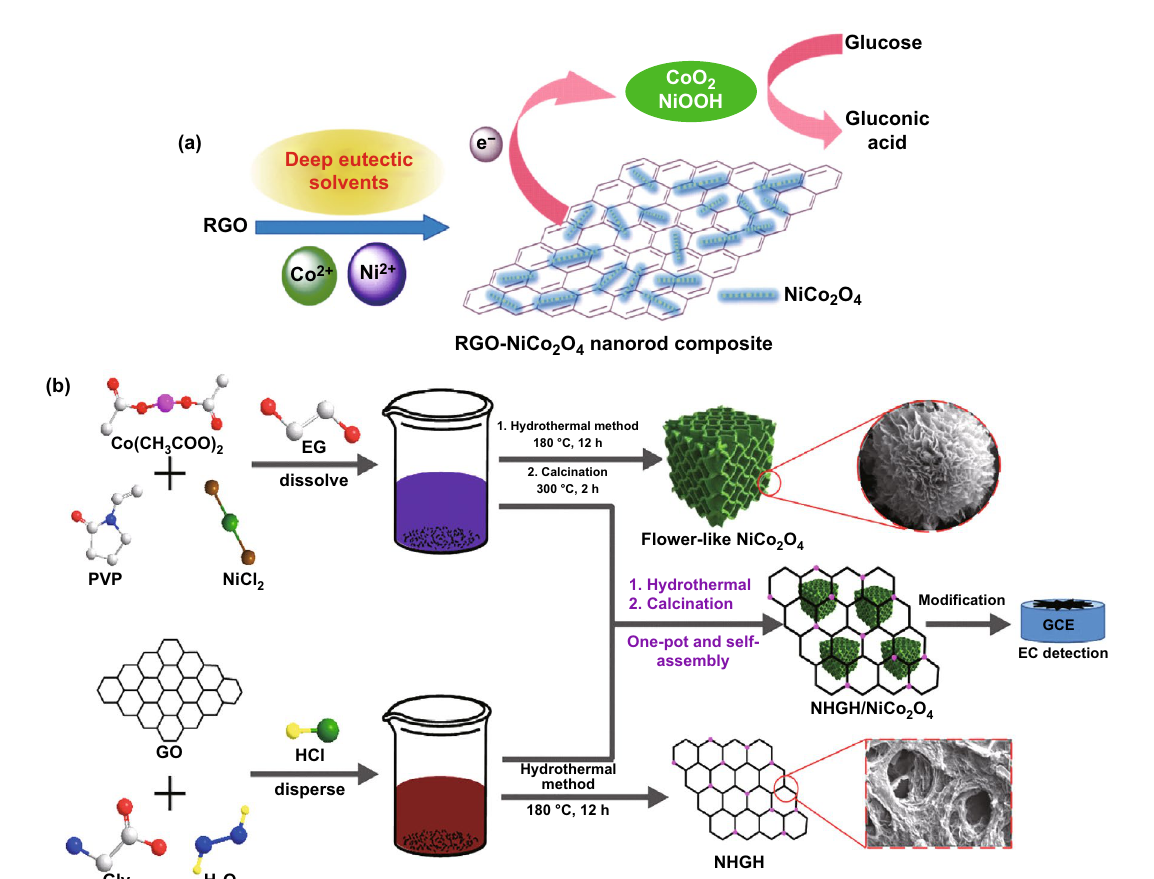
Fig. 28 a Proposed mechanism of glucose sensing using NiCo 2 O 4 nanorods/rGO/Nafion composite-modified GCE. Reproduced with permis- sion from Ref. [247]. Copyright © 2018 Elsevier Ltd. b Schematic presentation of the synthesis of the NHGH/NiCo 2 O 4 electro-catalyst for non- enzymatic glucose sensing, Reproduced with permission from Ref. [38]. Copyright © 2019 Elsevier